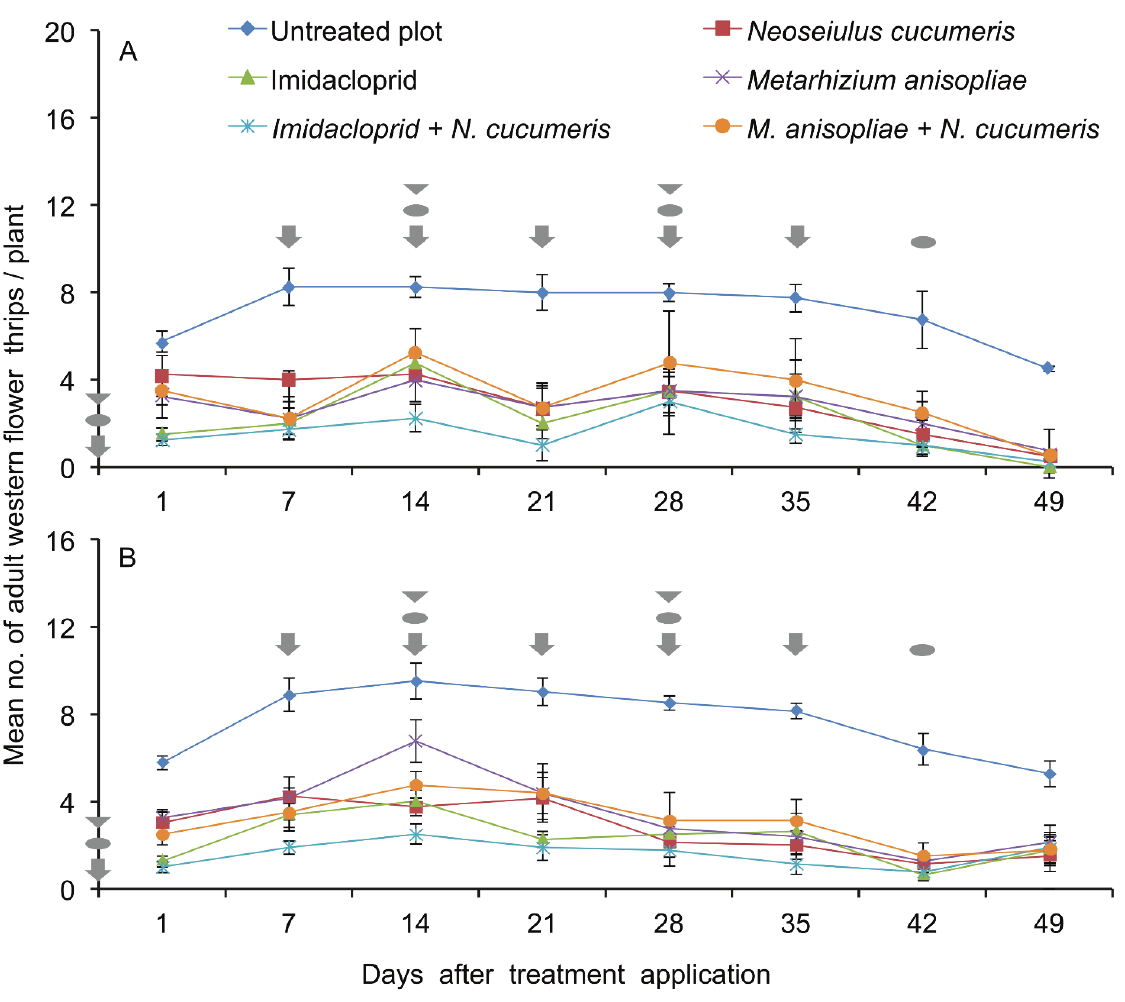
Figure 1. Mean (± SE) number of adult western flower thrips per plant recorded on field-grown French beans in the various treatments over time by plant tapping in March to June ( A ) and June to September ( B ) 2011 at KALRO-Embu, Kenya. Where = application of imidacloprid in respective treatments; = release of Neoseiulus cucumeris in respective treatments; and = application of Metarhizium anisopliae in respective